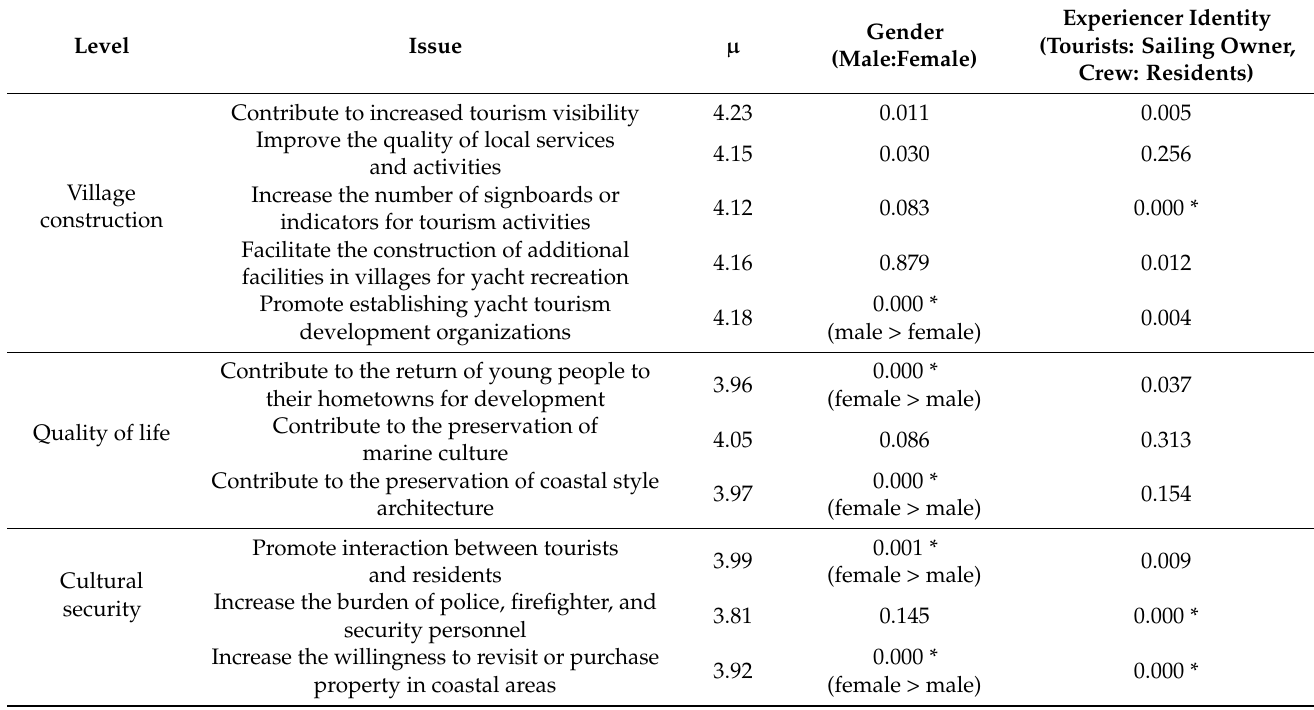
Table 5. Perception analysis of the impact on village social development.